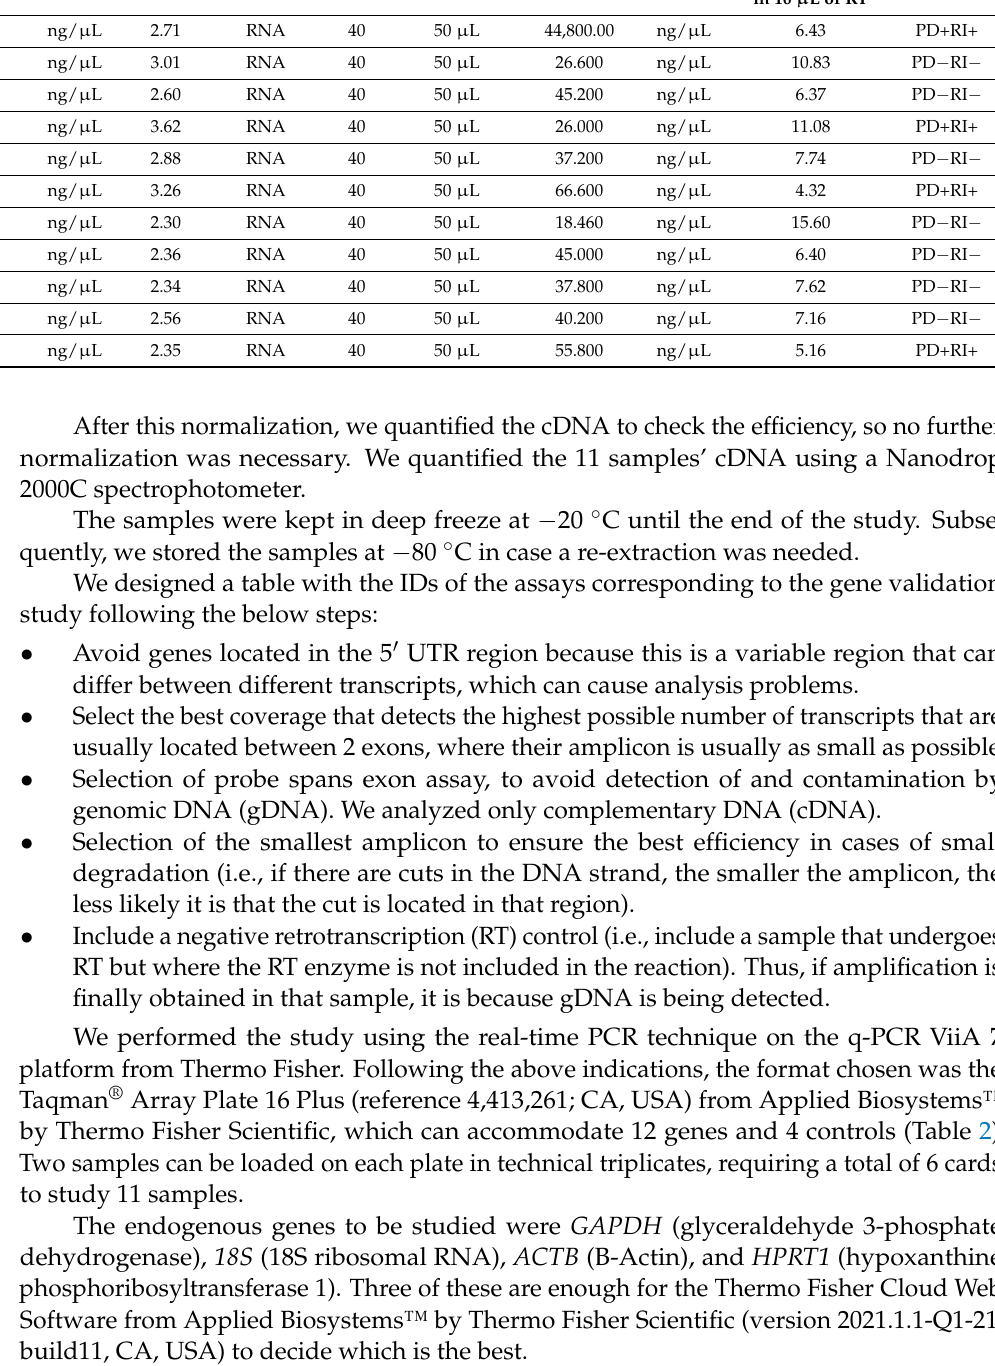
Table 1. Quantification and normalization of RNA per sample to 288 ng total at 16 µ L RT. Sample